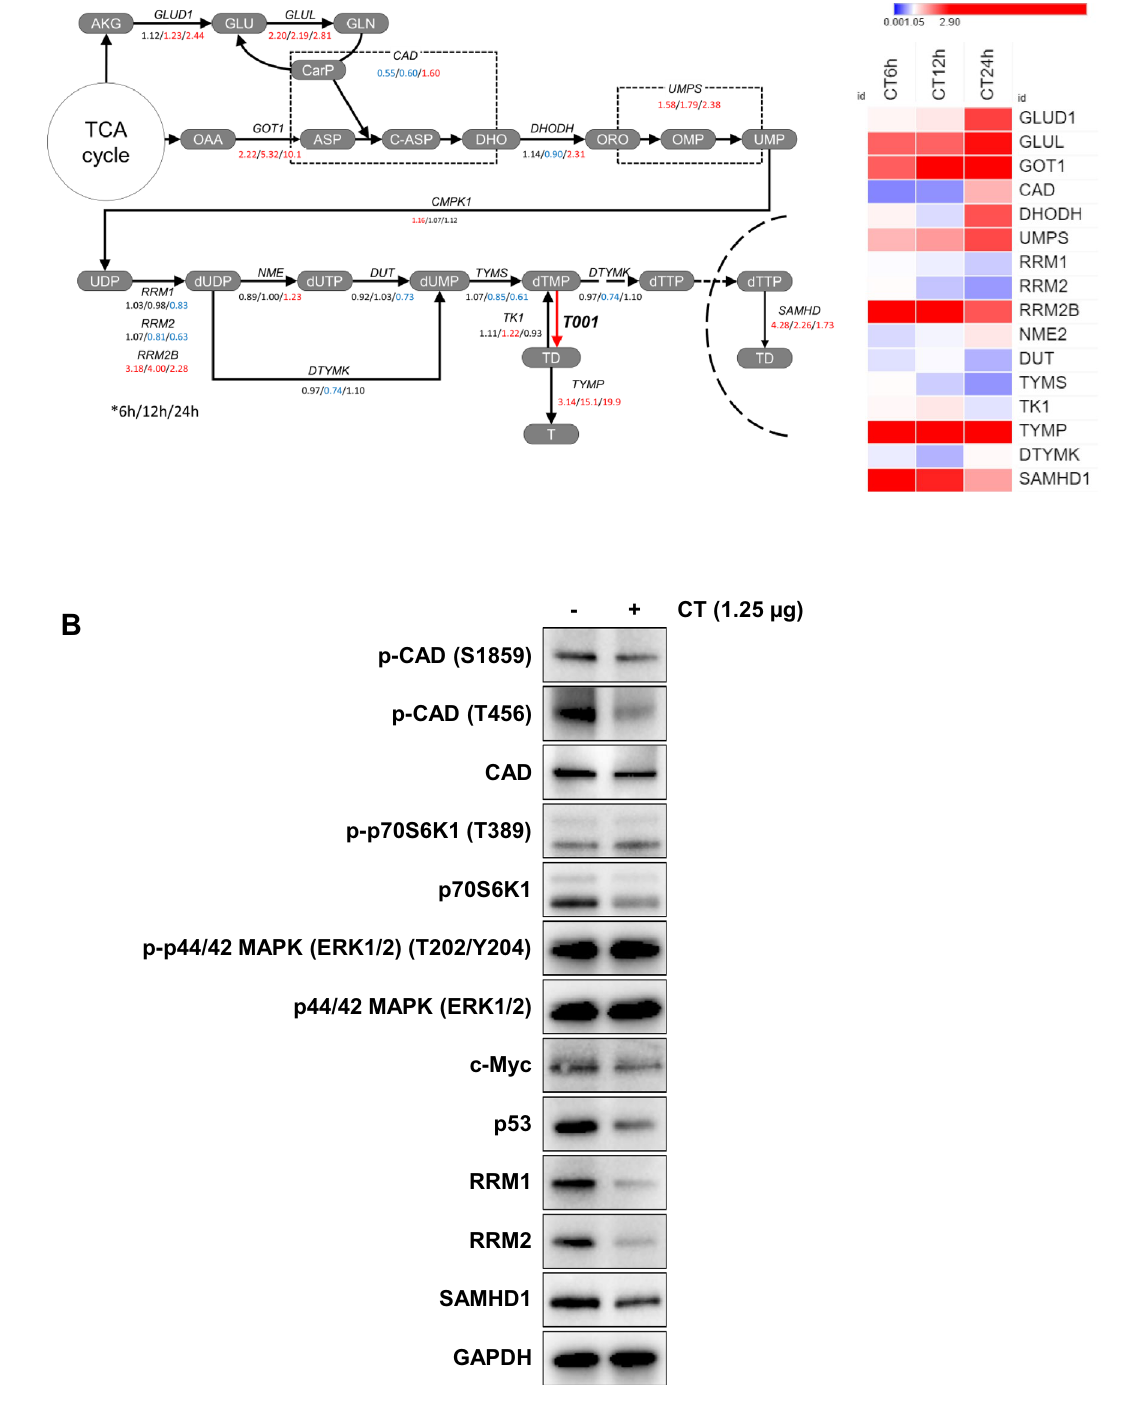
Figure 3. Expressional changes of essential pyrimidine biosynthetic enzymes regulated by oncogene driven signaling. ( A ) RNAseq analysis of pyrimidine metabolic pathway (6 h/12 h/24 h). AKG: α-ketoglutarate, GLU: glutamate, GLN: glutamine, CarP: carbamoyl phosphate, OAA: oxaloacetate, ASP: aspartate, C-ASP: carbamoyl-aspartate, DHO: dihydroorotate, ORO: orotate, TD: thymidine, T: thymine, GLUD: glutamate dehydrogenase, GLUL: glutamate-ammonia ligase, GOT: glutamic-oxaloacetic transaminase, CAD: carbamoyl-phosphate synthetase, aspartate transcarbamylase, and dihydroorotase complex, DHODH: dihydroorotate dehydrogenase, UMPS: UMP synthetase, RRM1/2: ribonucleotide reductase catalytic subunit M1/2, RRM2B: ribonucleotide reductase regulatory TP53, NME: nucleoside diphosphate kinase, DUT: dUTPase, TYMS: thymidylate synthase, DTYMK: deoxythymidylate kinase, TK1: cytosolic thymidine kinase, TYMP: thymidine phosphorylase, SAMHD: SAM and HD domain containing dNTP triphosphohydrolase, T001: enzyme translated from CT. ( B ) Western blot analysis of MDA-MB-231 cells was carried out to investigate the expression changes of essential pyrimidine biosynthetic enzymes and the oncogene-driven signaling proteins. Original blots are presented in Supplementary Information (Figure Raw